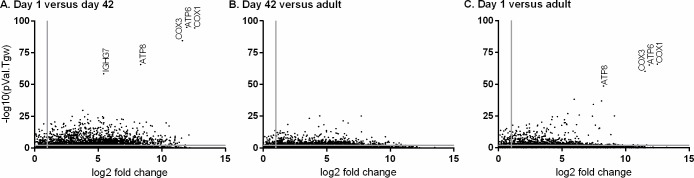
Differential gene expression between day 1 foal, day 42 foal, and adult horse samples.Gene expression levels were compared between groups and plotted with log2 fold expression on the x-axis and–log10 p-value on the y-axis. Gray lines show threshold for levels of differential expression (fold change ≥2) and significance (p-value <0.01). A) Comparison of gene expression from day 1 versus day 42 foal samples; B) comparison of gene expression from day 42 foal versus adult samples; and C) comparison of gene expression from day 1 foal versus adult samples.